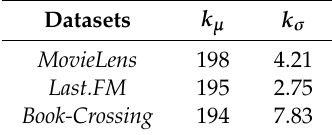
Table 7. The average ( k µ ) & standard deviation ( k σ ) of the observed ratings.